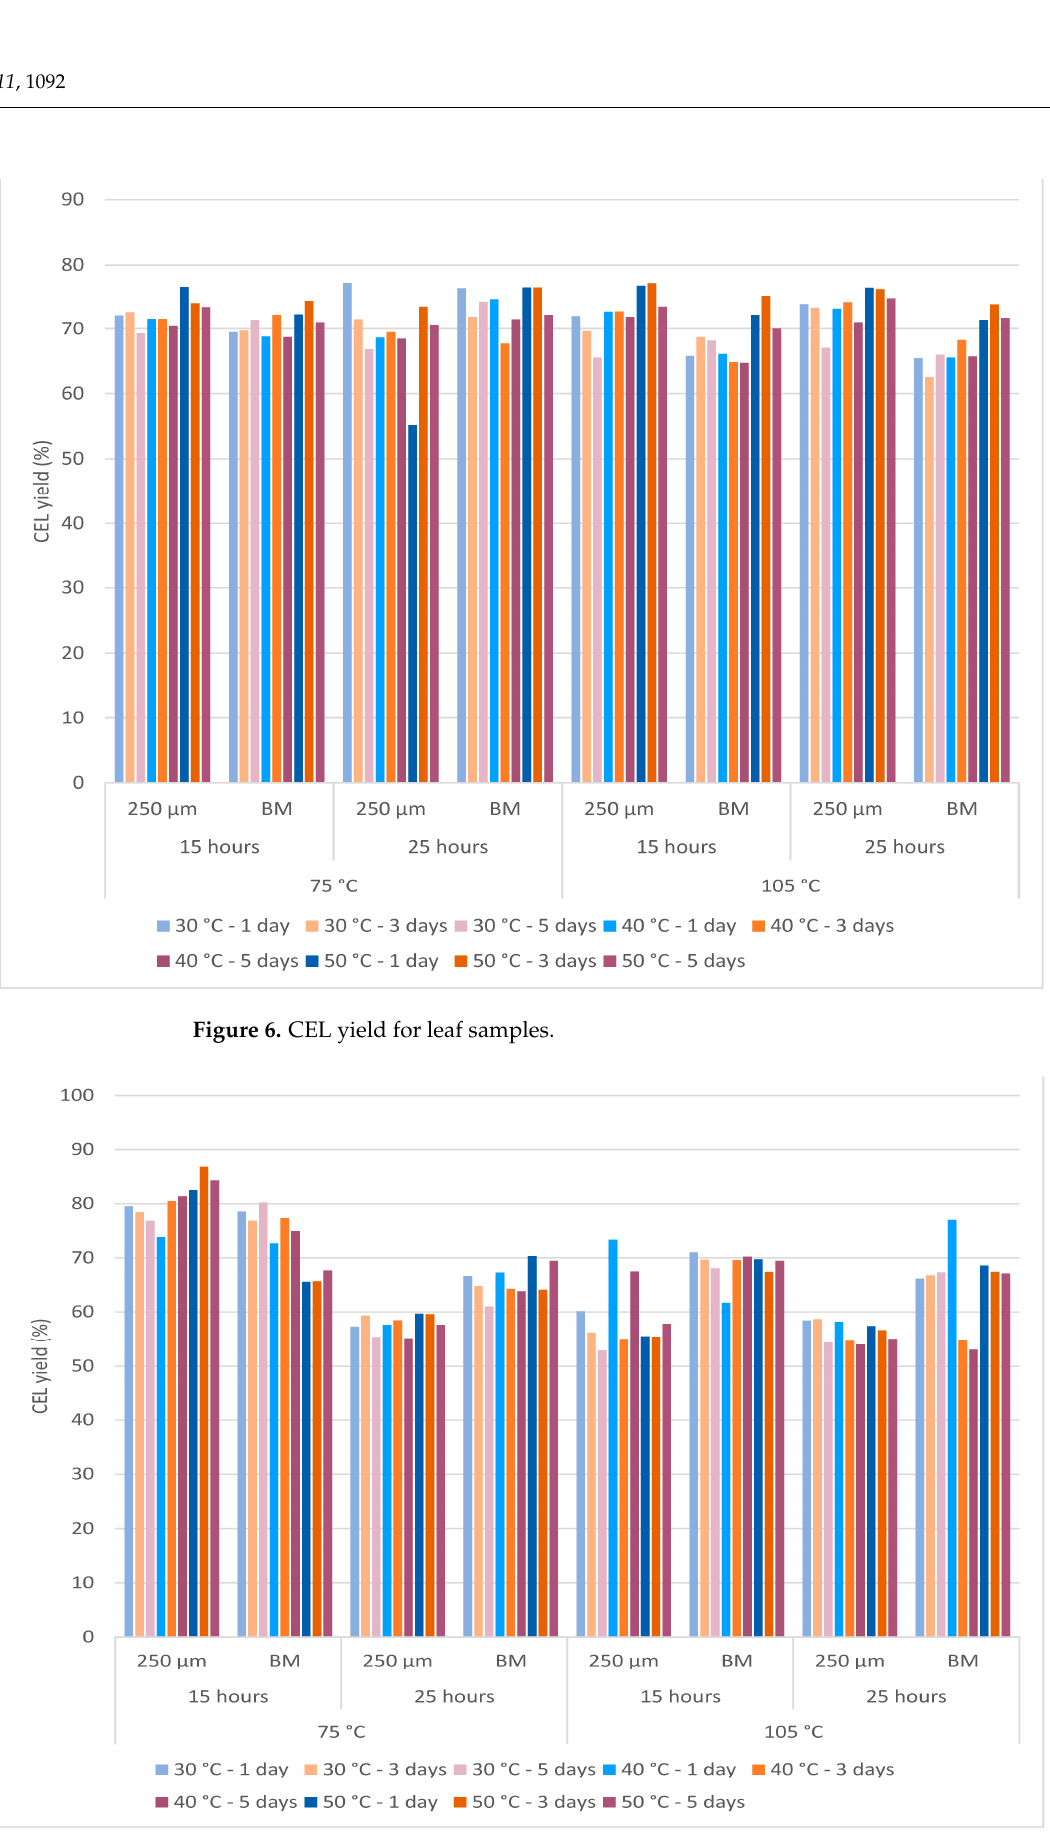
Figure 7. CEL yield for stem samples.